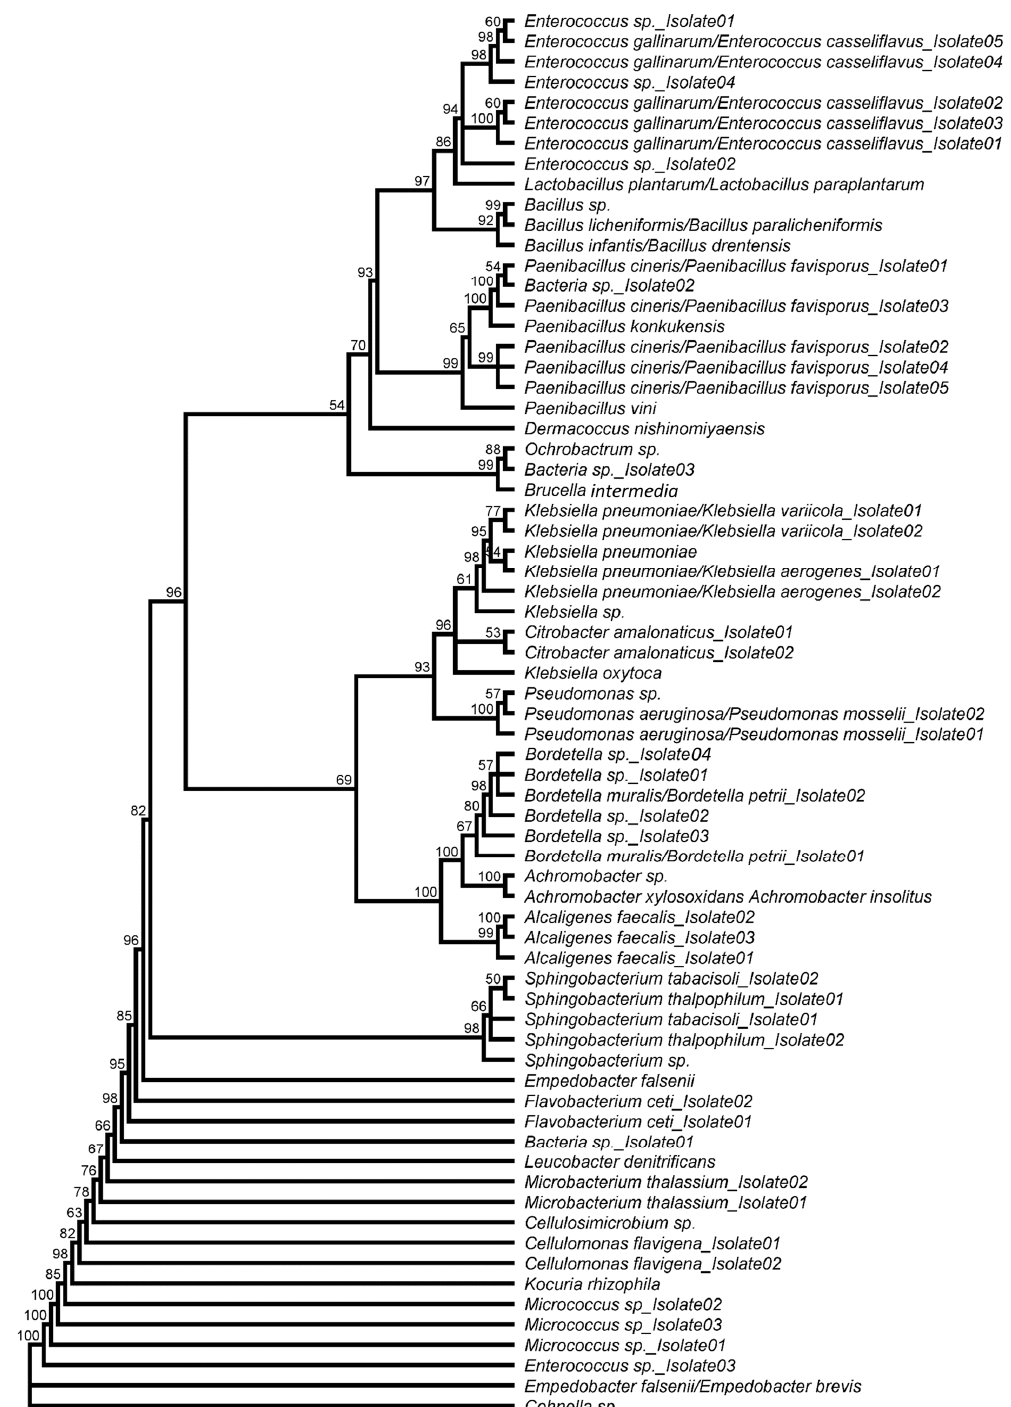
Figure 3. Phylogenetic analysis of all bacterial BSF gut isolates based on 16S rRNA sequences. Unrooted neighbor-joining tree using the JC69 Jukes and Cantor substitution model. The numbers indicate support for clade branching (%) of 1000 bootstrap replications.